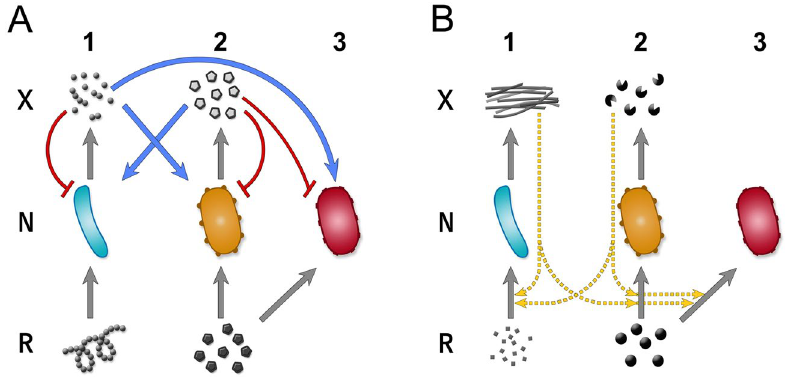
Figure 1. Models of cross-feeding ( A ) and cross-facilitation ( B ). Species N i consumes resource R i and produces X i (grey arrows). ( A ) Trophic cross-feeding. Product X i represents a self-inhibiting (red curve) waste material of species N i that can be consumed by species N j , serving directly as food (blue arrows). ( B ) Enzymatic cross- facilitation or collaborative-feeding. Product X i of species N i is an enzyme providing cooperative help (e.g. extracellular digestion of resources, formally equivalent to any form of indirect aid of a protective mutualism) to partner species and to itself by enhancing the consumption of resources R i (dashed yellow arrows). In both cases, a mutant species N 3 (red cell) may appear that inherits the properties and interactions of N 2 (yellow cell) but does not produce